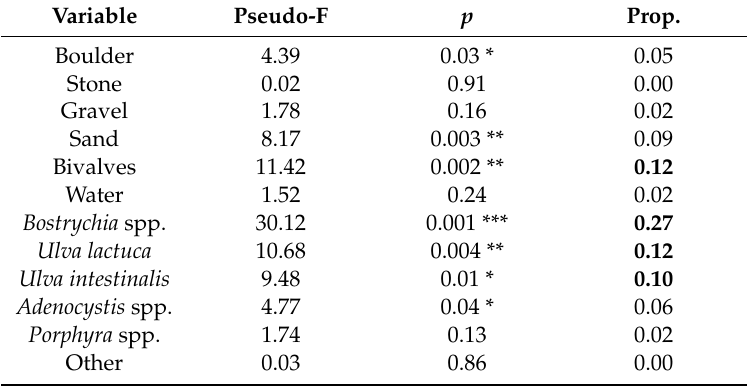
Table 3. Marginal tests obtained from the Distance-Based Linear Modelling procedure for the 12 environmental variables measured within the three tidal zones in R ó balo Bay, Navarino Island, Chile. Asterisks indicate significant associations with the presence of T. magellanicus (* p < 0.05, ** p < 0.01, *** p < 0.001), and values in bold the most highly associated variables. (Prop. = proportion of variability).